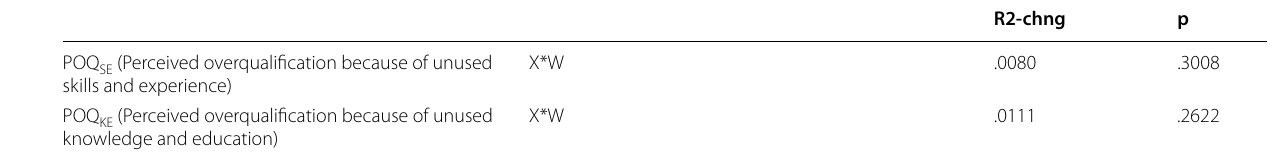
The significance of parameters at the level of 0.95